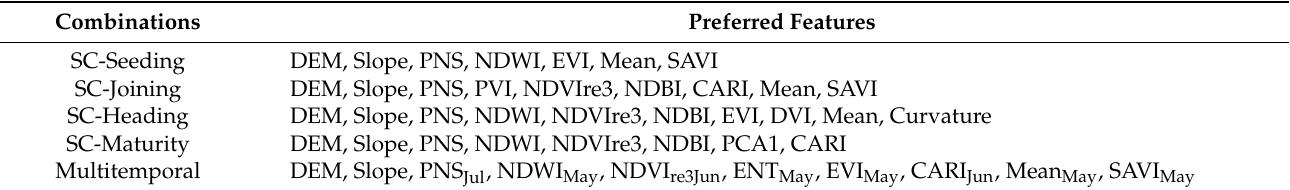
Table 5. Preferred results for